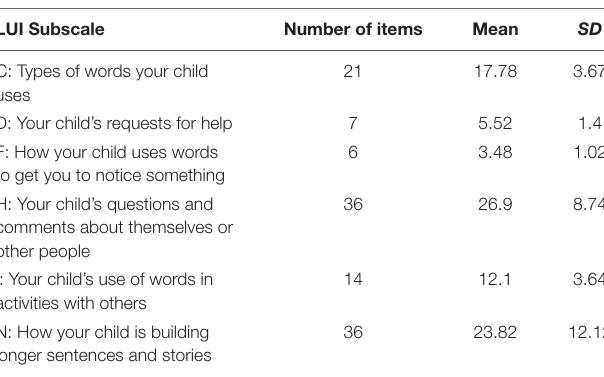
TABLE 2 | Children’s raw scores on the six LUI subscales based on parental reported use of English (sole or in addition to home language) ( N = 335). LUI